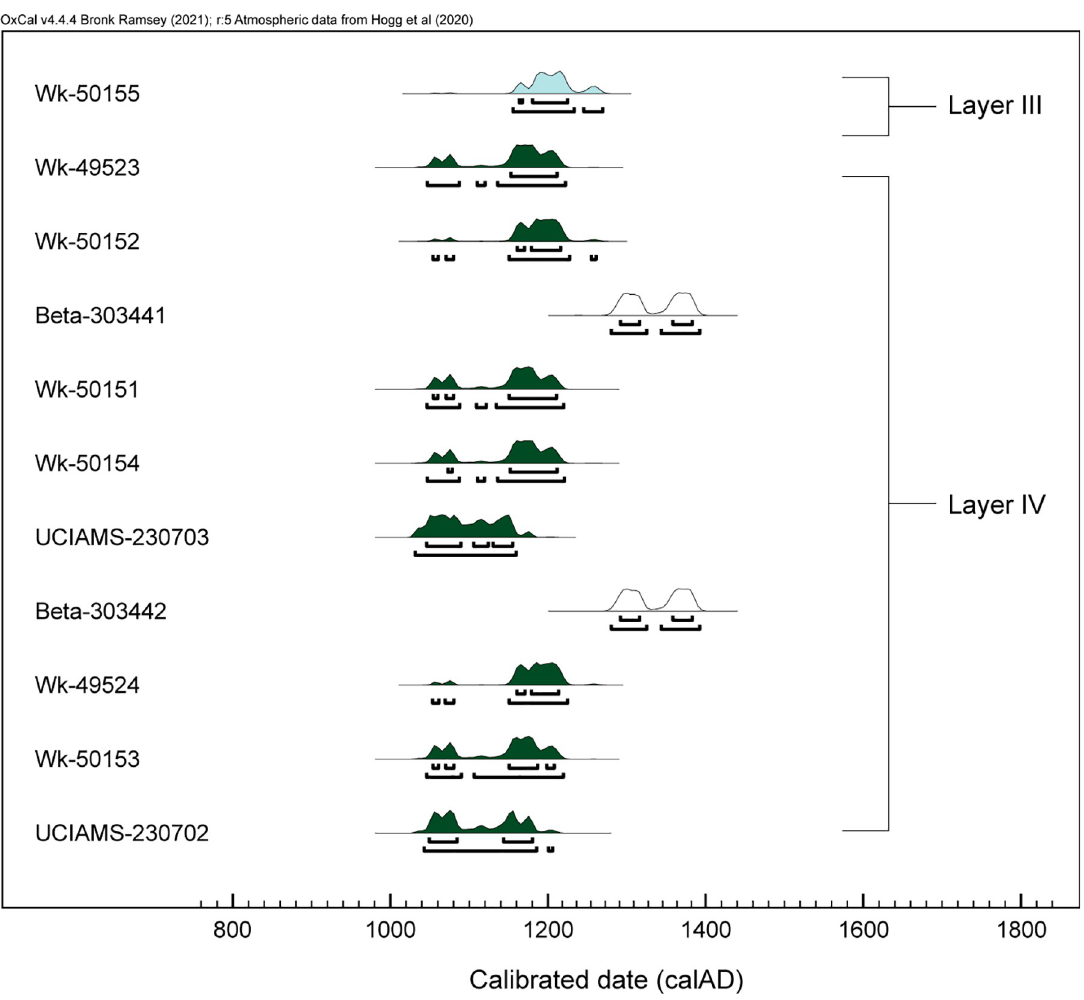
Fig 4. Oxcal plot of calibrated AMS results from Layer IV, Trench 1, Ho‘oumi Beach (see Table 2 and text for sample details).